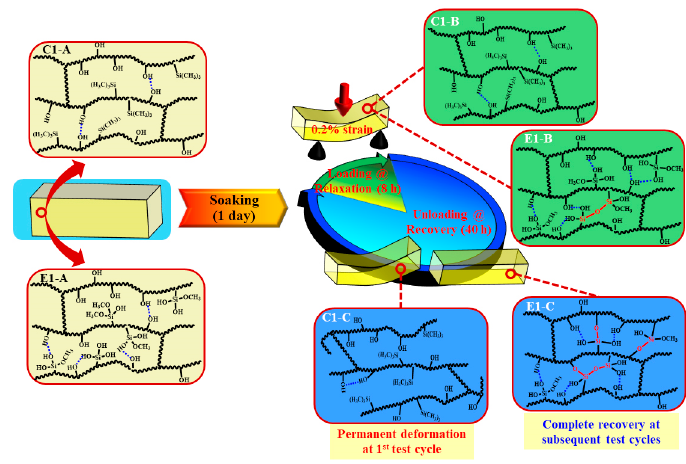
Scheme 3. Schematic illustration of evolution of the polymethacrylate-based network structures during the recurring stress relaxation test: (C1 / E1-A) C1 / E1 network structures after soaking in water for 1 day at 37 ◦ C; (C1 / E1-B) C1 / E1 network structures at the stress loading and relaxation; (C1 / E1-C’) C1 / E1 network structures during the recovery period. (Blue dash line presents the hydrogen bonds